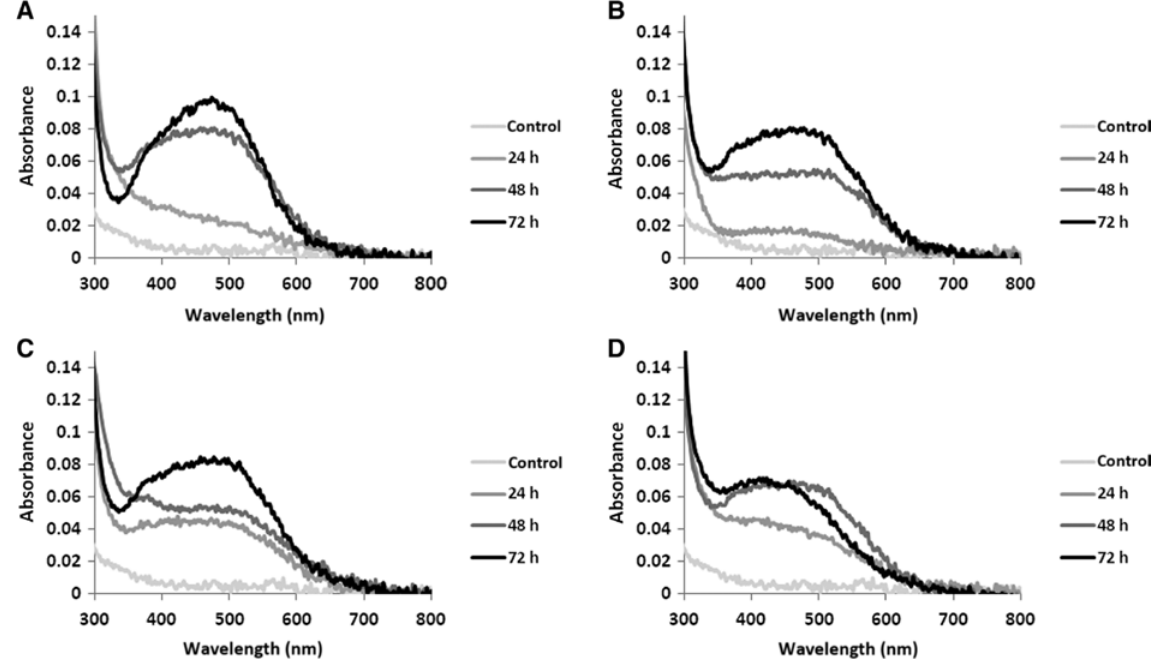
Figure 1: The absorption spectra of AgNPs biosynthesized after incubation time (24, 48 and 72 h) by N. valliformis OT1, S. palmae OF1, OF2 and also S. alkaliphilus IF19 strains. N. valliformis OT1 strain (A); S. palmae OF1 strain (B); S. palmae OF2 strain (C); S. alkaliphilus IF19 strain